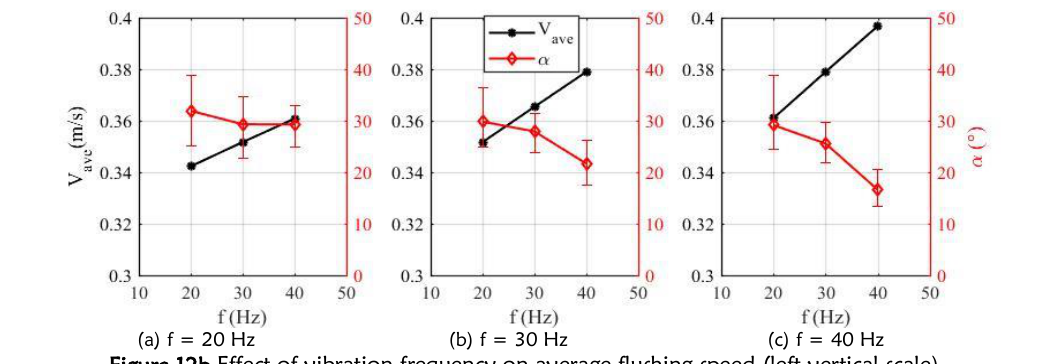
Figure 12b Effect of vibration frequency on average flushing speed (left vertical scale) and taper angle (right vertical